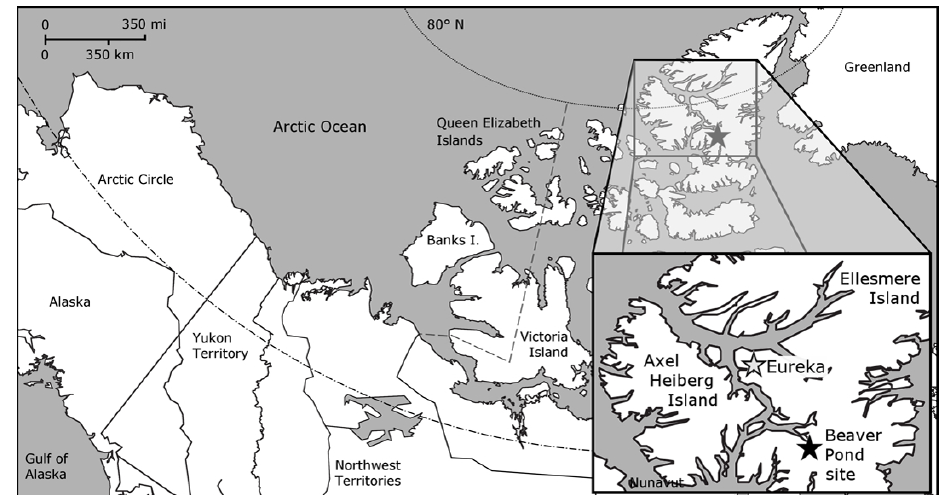
Figure 2. Map of the Canadian Arctic Archipelago, highlighting the location of the Beaver Pond site (black star; 78 ◦ 33 (cid:48) N; 82 ◦ 25 (cid:48) W) and Eureka Climate Station (gray star; 80 ◦ 13 (cid:48) N, 86 ◦ 11 (cid:48) W – used for modern climate comparison) on west–central Ellesmere